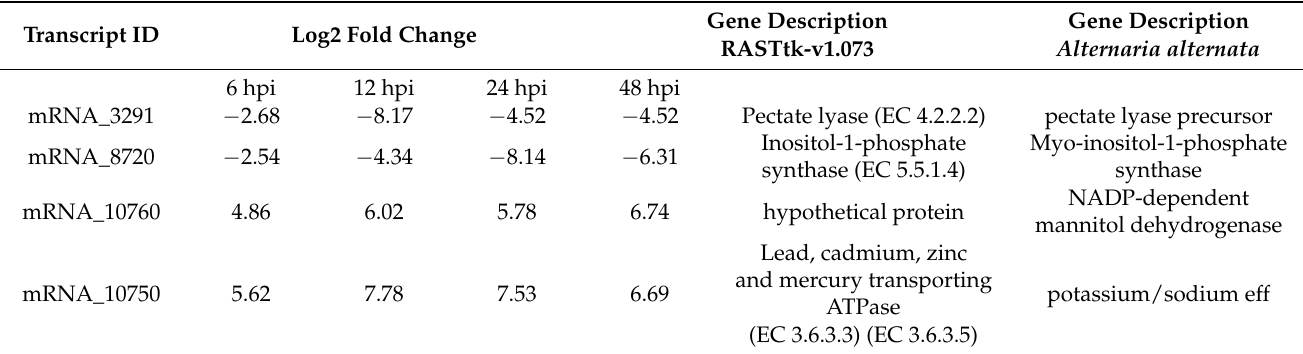
Table 3. Differentially expressed A. solani transcripts overlapping in A. solani inoculated samples at 6, 12, 24 and 48 hpi. Transcript ID, log2 fold change, and the gene descriptions based on the RATtk v1.073 and BLAST analysis are displayed.